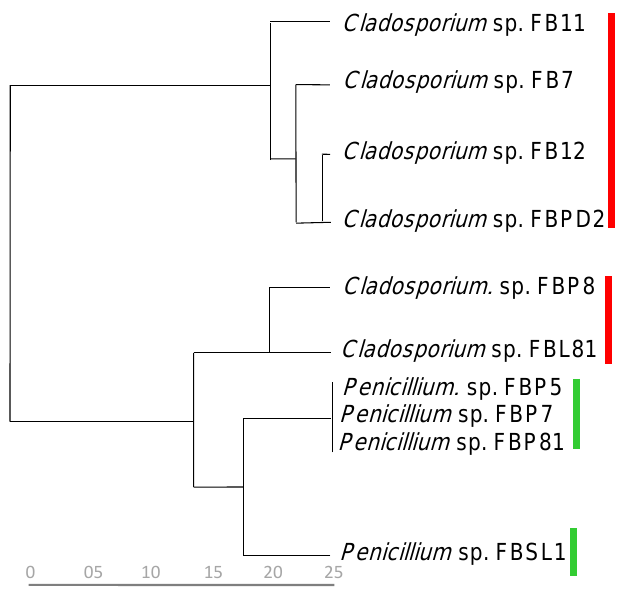
Figure 7. Dendrogram inferred from the utilization of 95 carbon sources. The analyses for constructing the dendrogram were performed based on the last five measurements (average from the replicates). Red and green marks are Cladosporium and Penicillium strains isolated in this study,